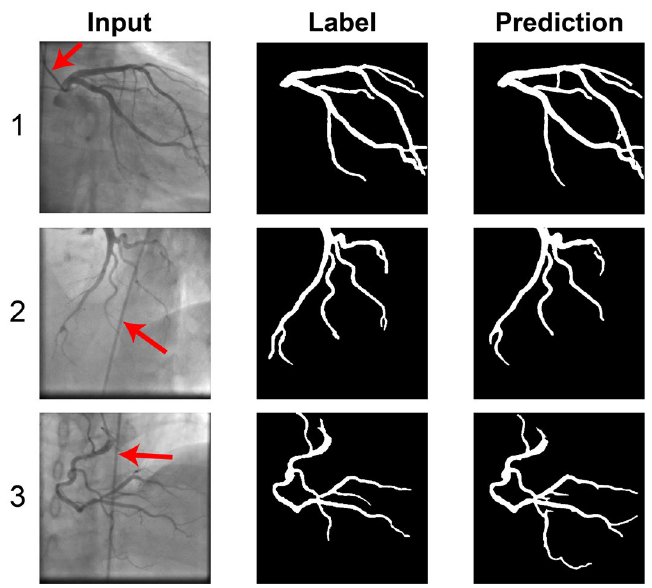
Figure 5. Examples of AngioNet segmentation on left coronary tree, taken at two different angles (1,2), and right coronary tree (3). AngioNet does not segment the catheter (red arrows), despite its similar diameter